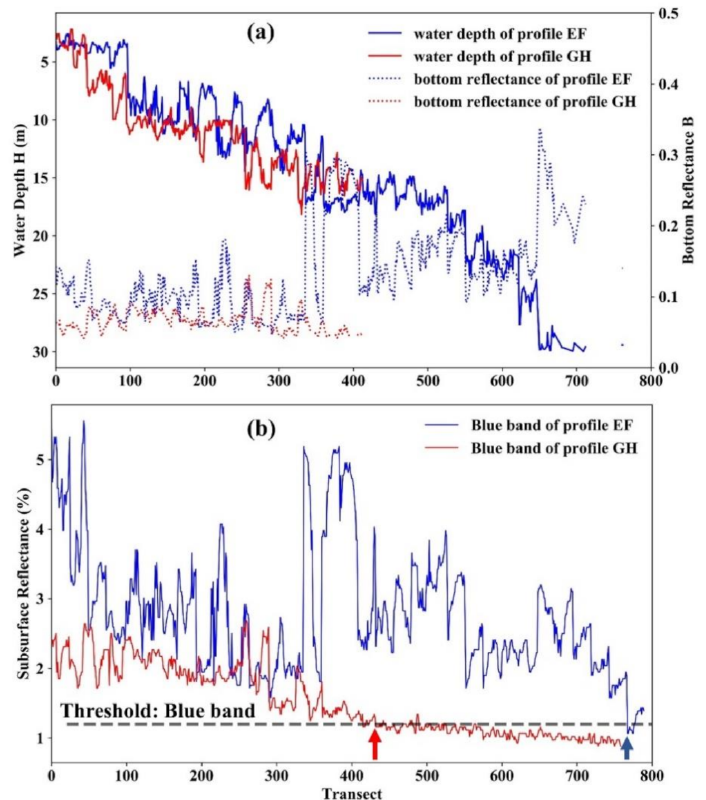
Figure 13. ( a ) Changing curves of the water depth and bottom reflectance along EF and GH . ( b ) Chang- ing curves of blue band subsurface reflectance along EF and GH . The dotted line represented the approximate threshold, above which the inversion range was within our detection. The red arrow represented the position corresponding to the threshold of GH , while blue arrow represented EF